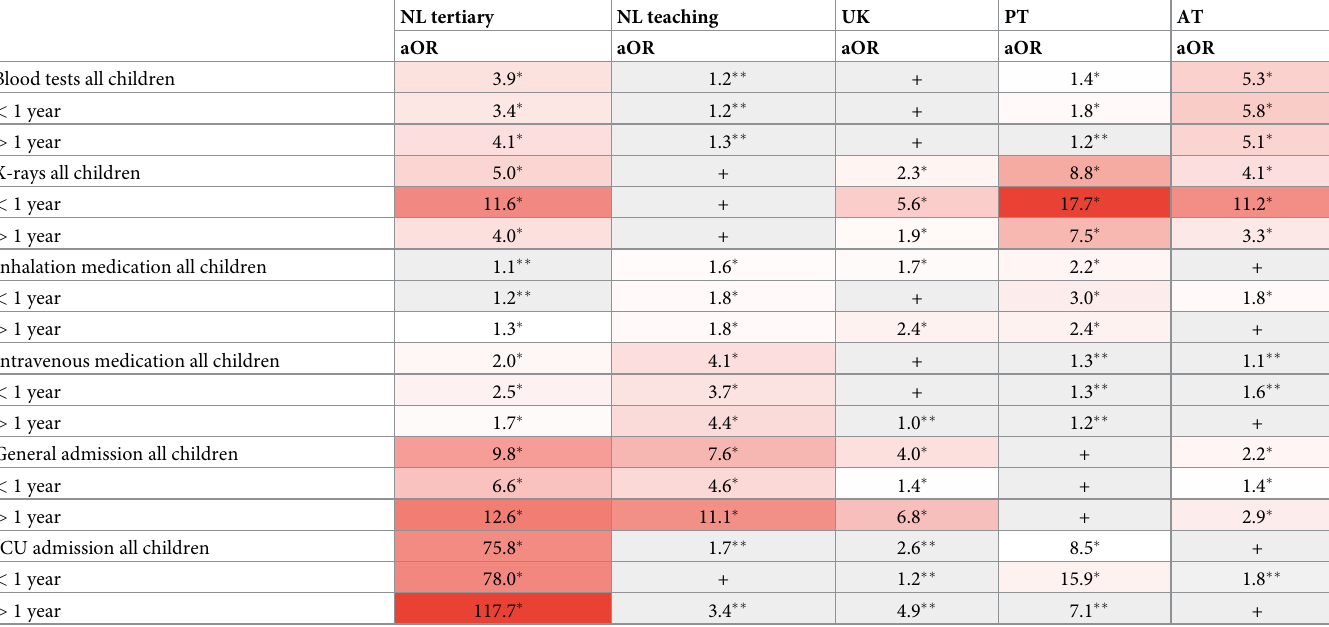
Table 2. Heatmap for different ages with odds ratios of resource use, corrected for patient characteristics #